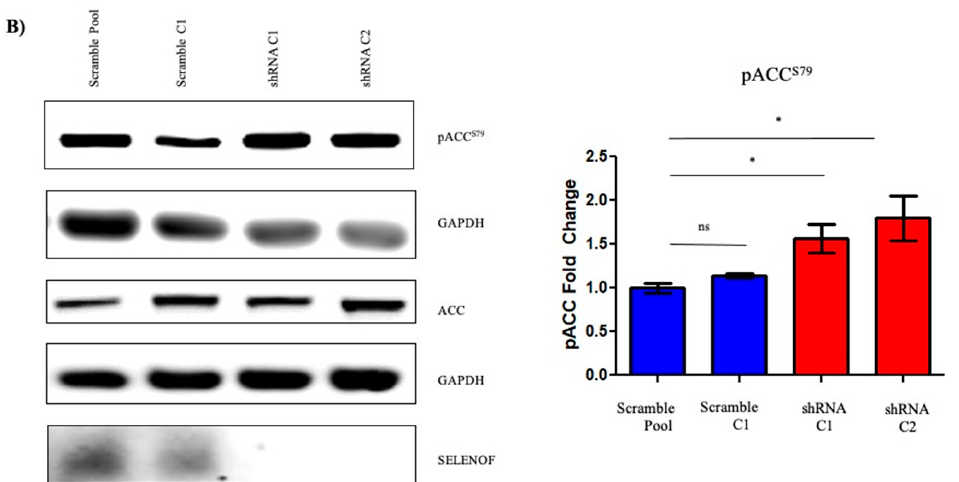
Figure 6. Reducing SELNENOF levels resulted in enhanced phosphorylation of AMPK and ACC in RWPE-1 cells. ( A ) Representative Western blots using anti-SELEONOF antibodies demonstrating the increase in the phosphorylation of AMPK in shRNA RWPE-1 cells without changes in total AMPK. ( B ) Representative Western blot and quantification of the changes in the phosphorylation of ACC and total levels of ACC. Florescent intensities were quantified and are shown next to the corresponding Western blots of three independent biological replicates. The data are presented as the mean ± SEM, n = 3, ns, not significant, * p < 0.05, ** p <